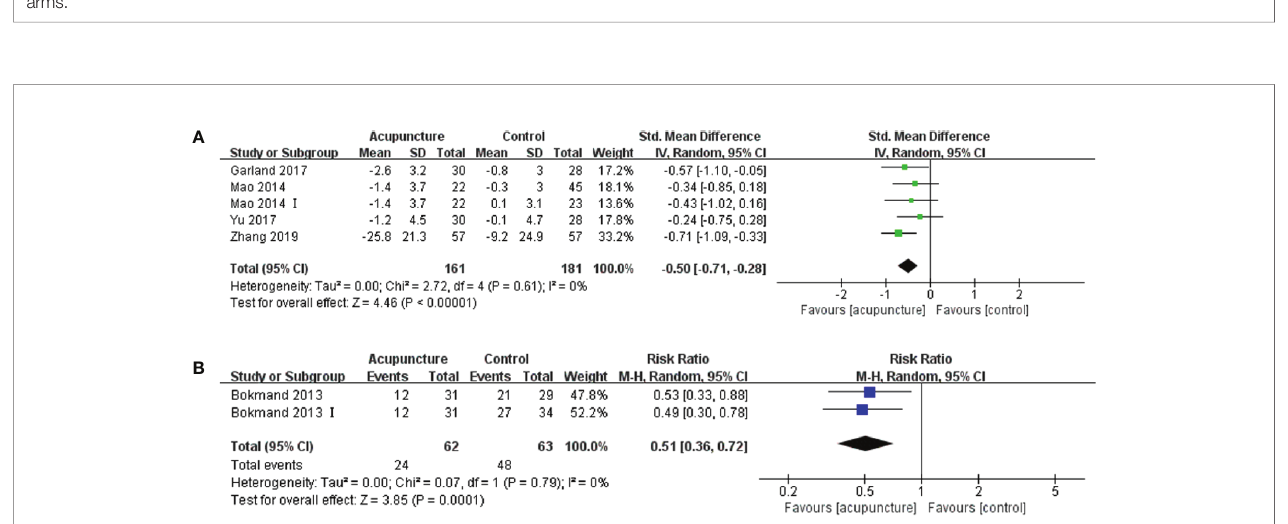
FIGURE 4 | Forest plot of the change of fatigue in BC patients treated with acupuncture and control from the bassline to end of treatment. IV, inverse variance; CI, Con fi dence Interval. The Roman numerals “ I ” followed the study ID represented the comparison of acupuncture versus no intervention in the study which had three arms.